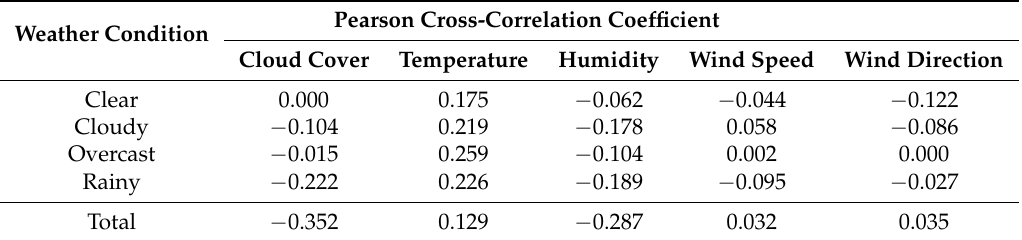
Table 4. Pearson product-moment correlation coefficient between input features and PV power output. Pearson Cross-Correlation Coefficient Weather Condition Cloud Cover Temperature Humidity Wind Speed Wind Direction Clear 0.000 0.175 − 0.062 − 0.044 Cloudy − 0.104 0.219 − 0.178 Overcast − 0.015